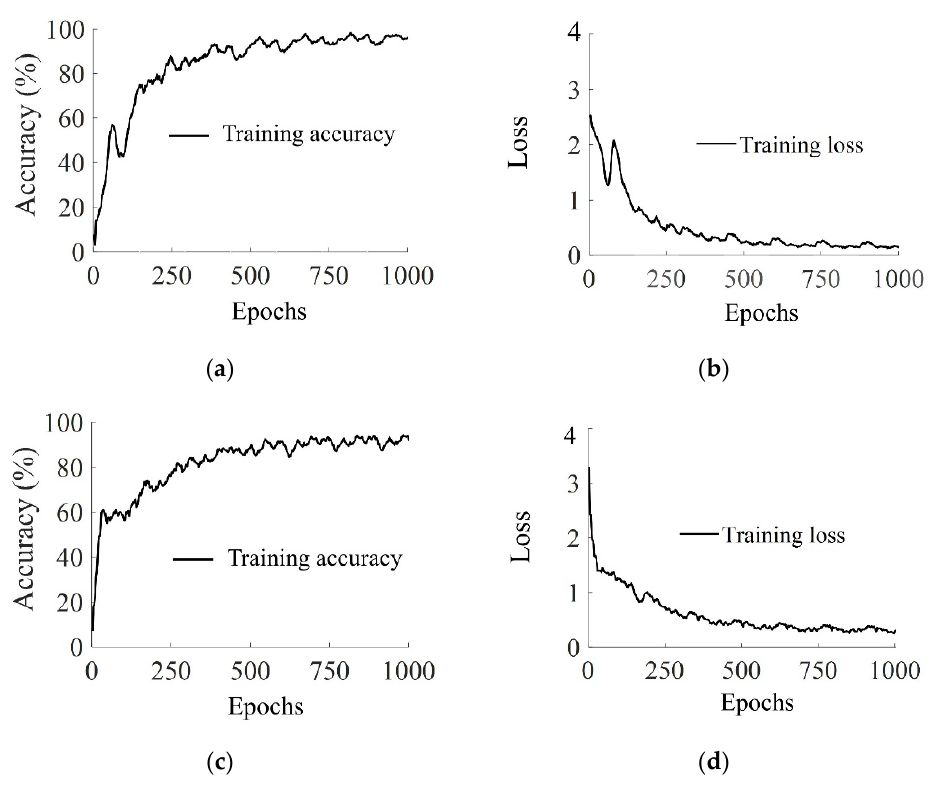
Figure 20. The training progress of different sound quality models: ( a ) Training accuracy and ( b ) Training loss of the monaural MFCC-CNN model; ( c ) Training accuracy and ( d ) Training loss of the binaural time series CNN model.